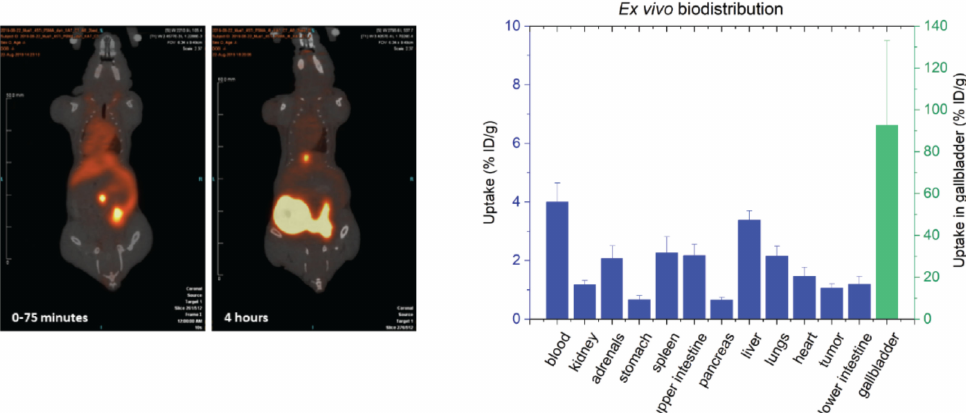
Figure 4. ( left ) PET / CT images (coronal plane) of one of the tumor-bearing mice (mouse no. 1) receiving [ 45 Ti]Salan-Ti-CA-PSMA ([ 45 Ti]- 3 ). Mouse no. 1 was dynamically scanned 0–75 min (left) and four hours (right) post-injection (p.i.); ( right ) The ex vivo biodistribution 4 h p.i. shown as the uptake of 45 Ti in the percentage of injected dose per weight of tissue. The values were an average for the four mice, and the error bars represent the standard deviation. The uptake in the gallbladder (green) can be read o ff the right y